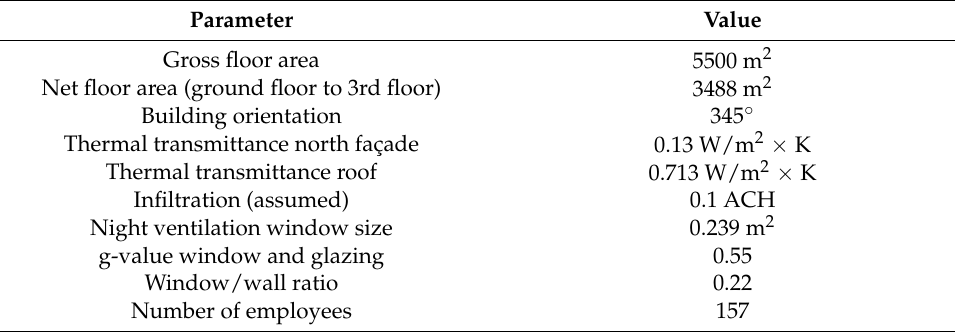
Table A1. Building characteristics and additional information.